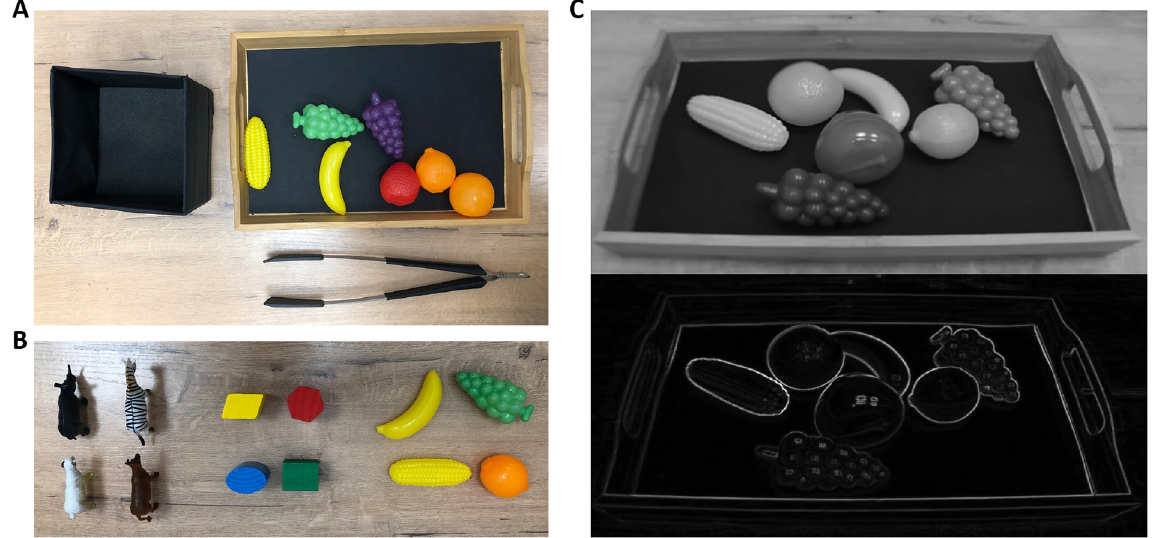
Fig 9. (A) A collection of 7 objects on a tray, and the open box as it was arranged on the desk before each trial of the tongs task in Experiment 3. (B) The 3 collections of objects used for the tongs task: plastic animals (left), wooden geometrical objects (middle), and plastic fruits-and- vegetables (right). (C) A gray-scale image and contour-drawing of the objects on the tray.